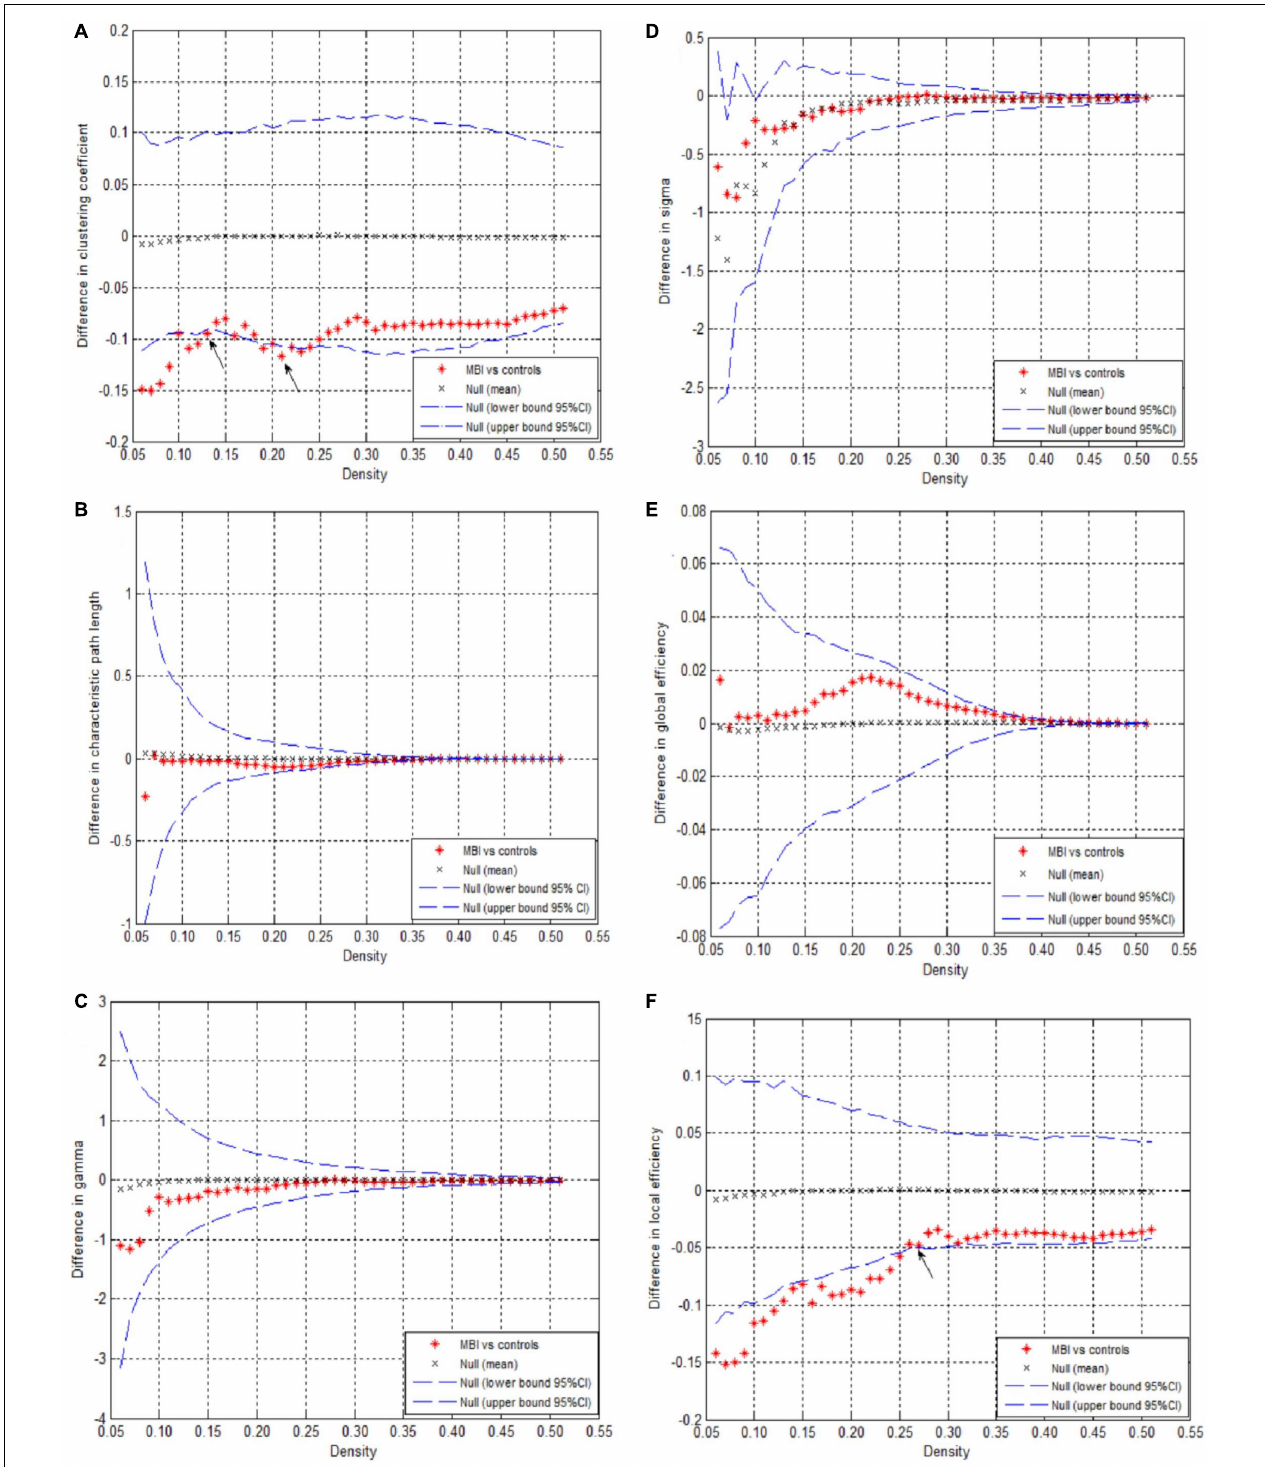
FIGURE 2 | Differences between normal controls and MBI patients in global network parameters as a function of network density. The 95% confidence interval and group differences in (A) Clustering coefficient, (B) Characteristic path length, (C) Gamma, (D) Sigma value, (E) Global efficiency, (F) Local efficiency. The * red marker denotes the difference between normal controls and MBI patients; the * signs lying outside of the confidence intervals indicate the density where the difference is significant at P < 0.05. The positive values indicate MBI patients > controls and negative values indicate MBI patients < controls. The arrows represents the critical point where there is a significant difference between the two